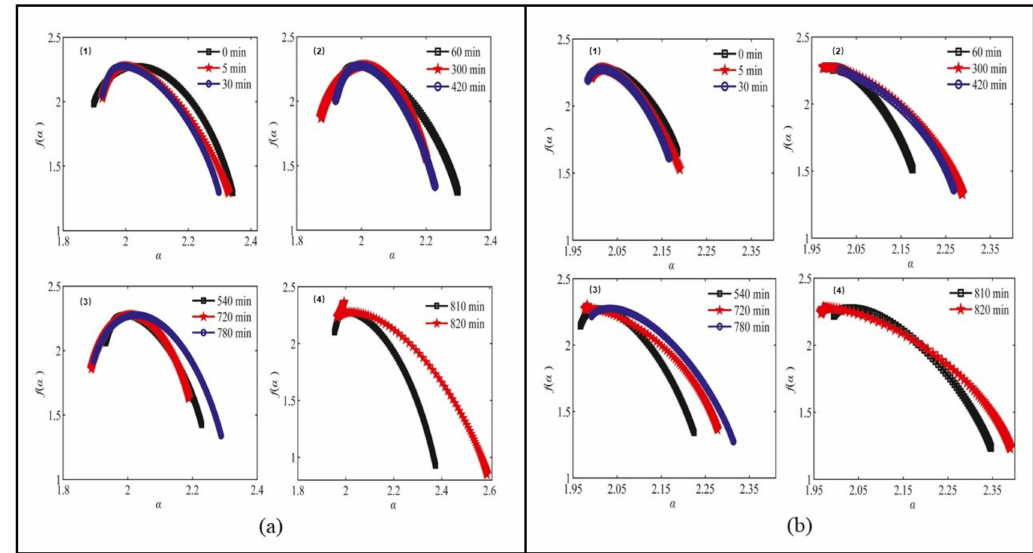
Figure 3. Multifractal spectrum surfaces ( a ) and ring surfaces ( b ) during the wear